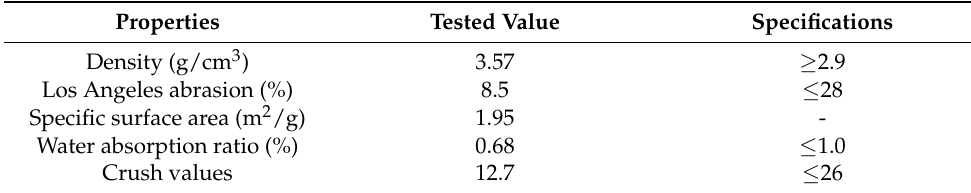
Table 1. Basic properties of SSP.